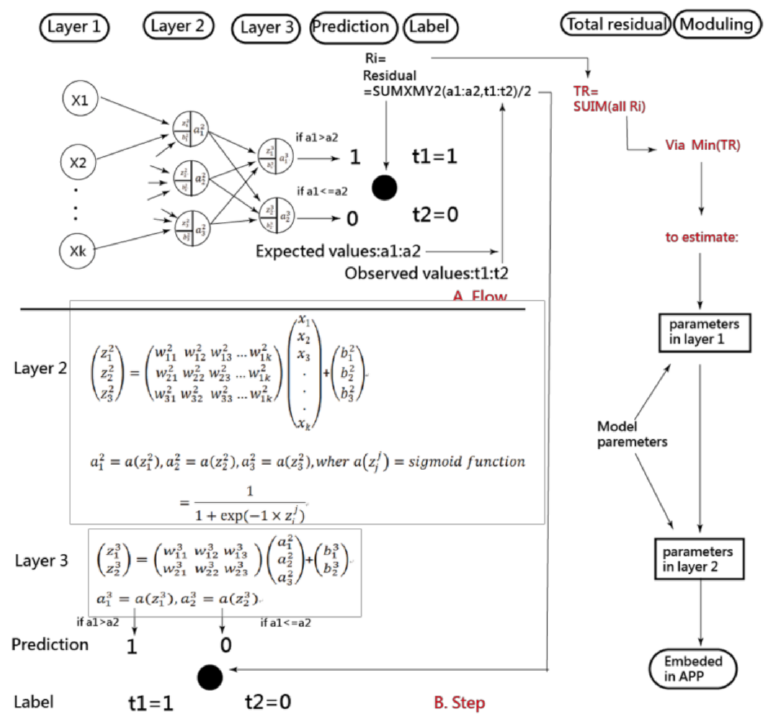
Figure 1. Process of estimating parameters in the ANN